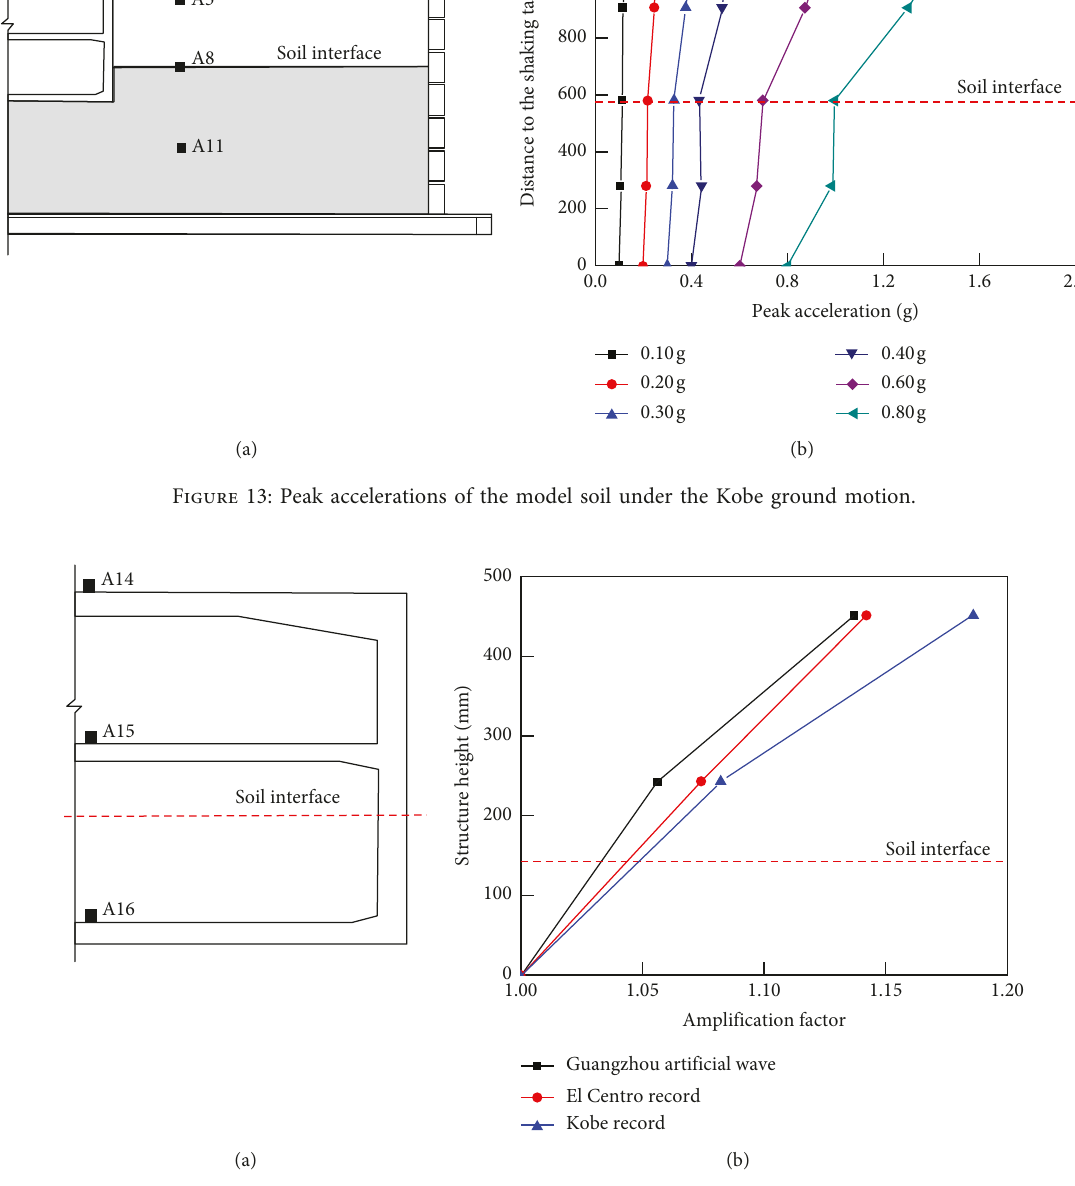
Figure 14: Peak acceleration amplification factor of the subway station structure in cases